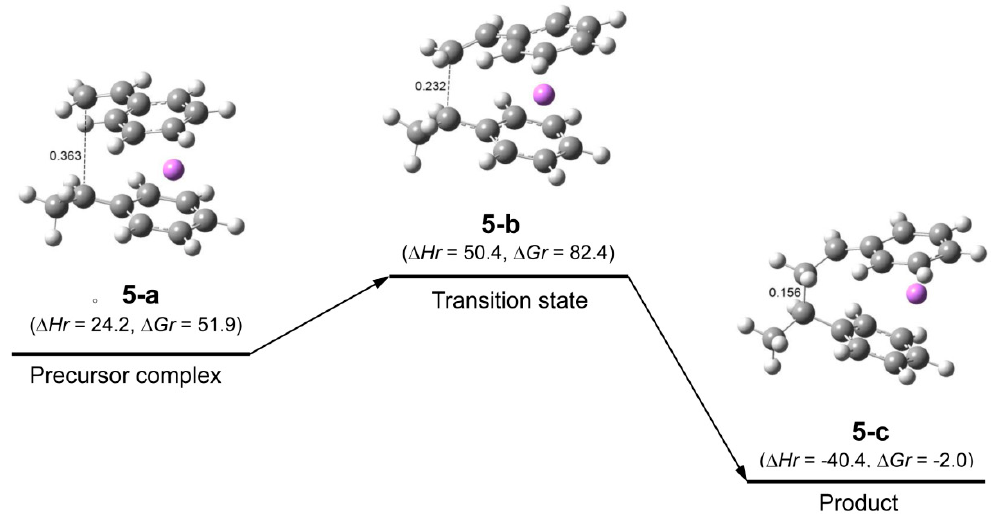
Figure 5. Reaction pathway for St / HStLi (system(mon-r)) in the gas phase originally shown in our previous paper. In each drawing the two carbon atoms participating in the reaction are connected by dotted or full line and the distance between them is shown in nm. ∆ H r and ∆ G r , the relative enthalpy and free energy, respectively, are expressed in kJ · mol − 1 .